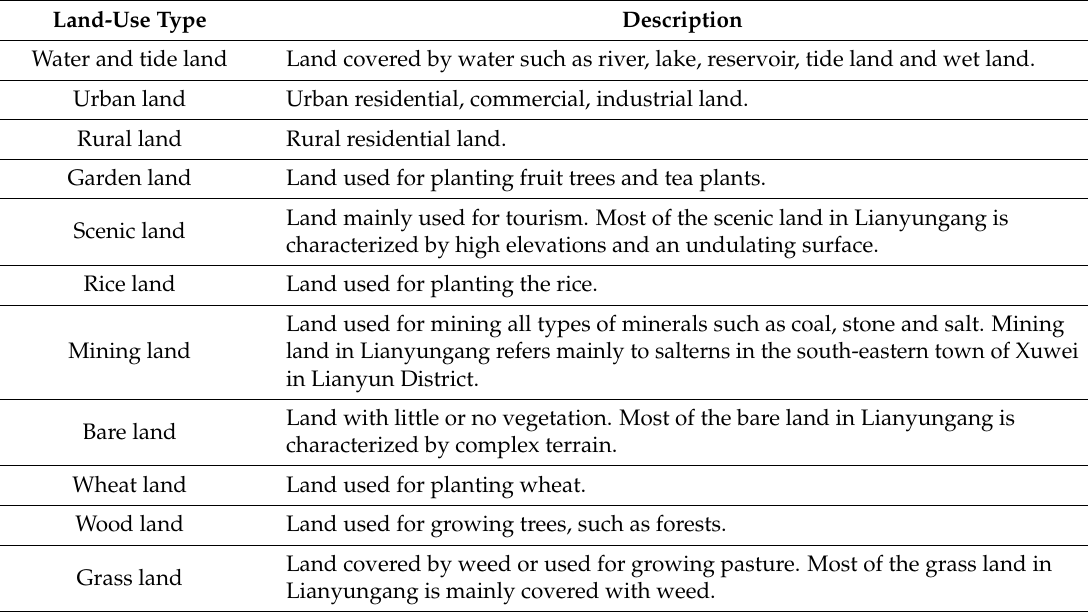
Table A1. The description of the 11 land-use types in